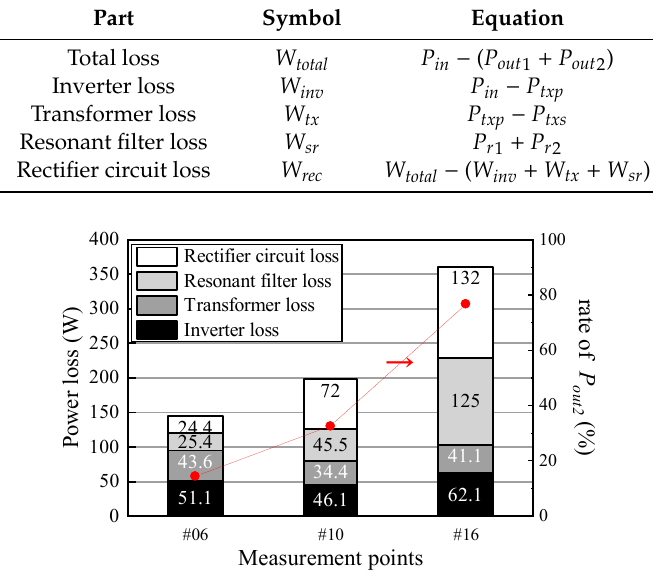
Figure 21. Loss analysis results.